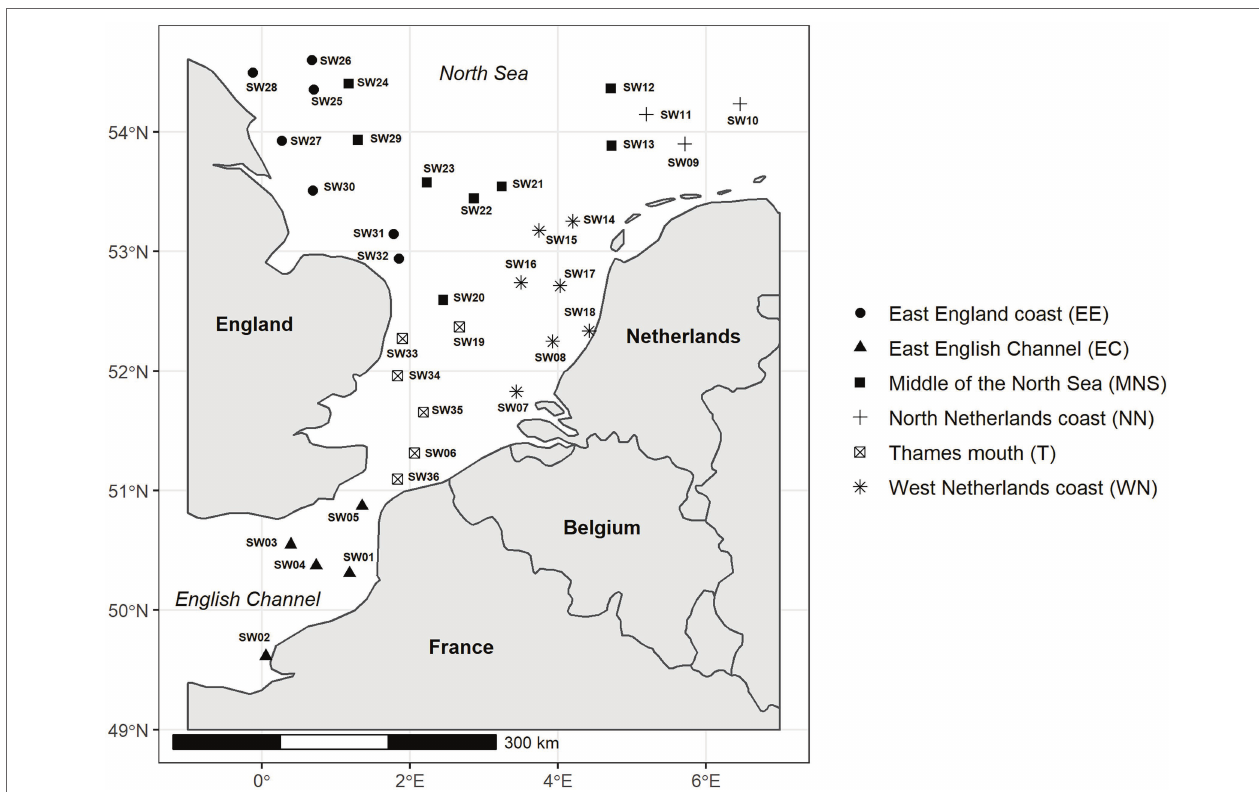
FIGURE 1 | The geographical locations of seawater sampling (SW01–SW36) sites in the English Channel and North Sea, divided into six defined